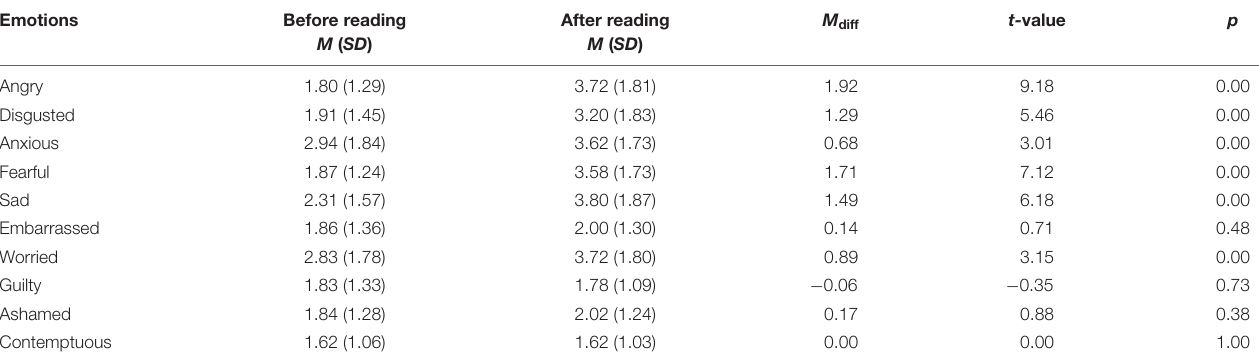
TABLE 2 | Emotions before and after reading the article (Study 1). Emotions Before reading M ( SD